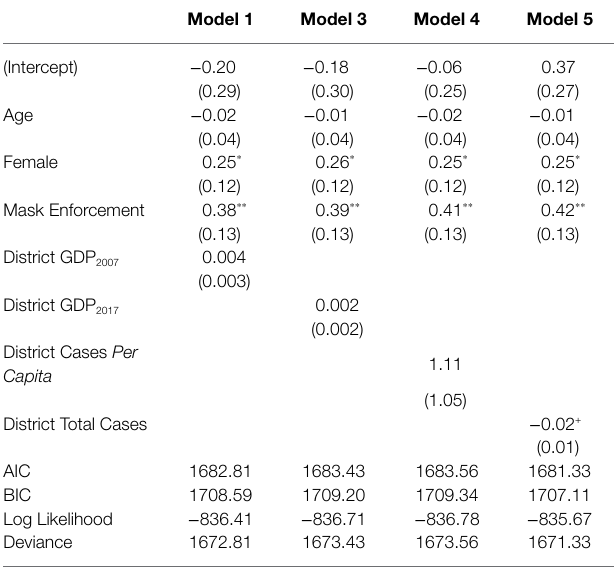
TABLE 3 | District wealth and COVID-19 cases demonstrate mixed